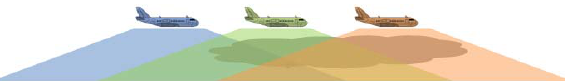
Fig. 3. Schematic of the geometry of the PSR along-track scans. The cartoon shows three successive along-track scan cycles, each shown in a different color. Each PSR swath spans ±70 ° off the nadir. The aircraft translates approximately 5.9 km during a full PSR scan cycle. It can be seen from the cartoon that a scan cycle moderately overlaps with its successive scan, but hardly overlaps with its second successive scan.